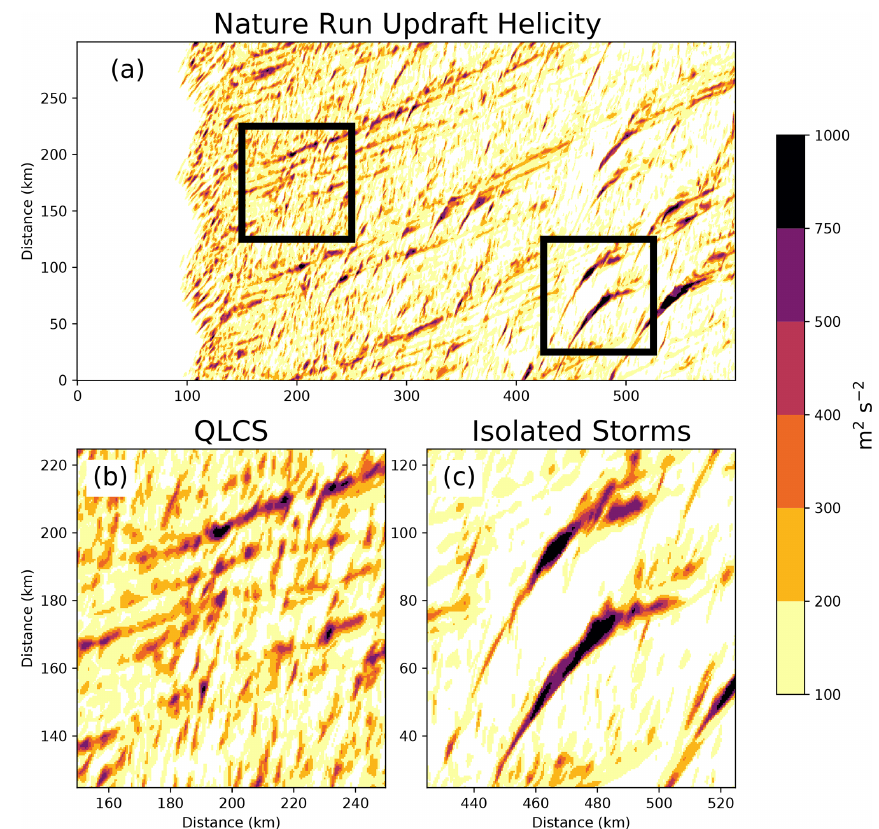
Figure 5. Nature run maximum updraft helicity over the (a) full experiment domain. Subdomains plotted in panels (b) and (c) highlight QLCS-embedded mesovortices (left black box) and isolated convection (right black box), respectively.